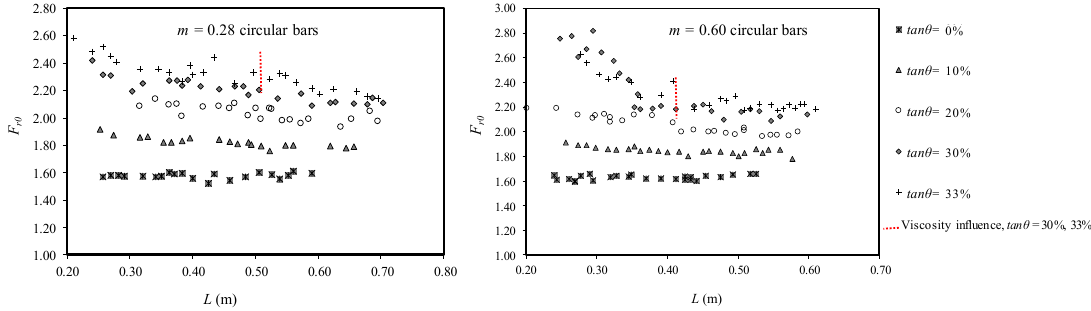
Figure 12. Froude number at the beginning of the rack F r0 as a function of the wetted rack length for circular bars with void ratios m = 0.28 and 0.60.